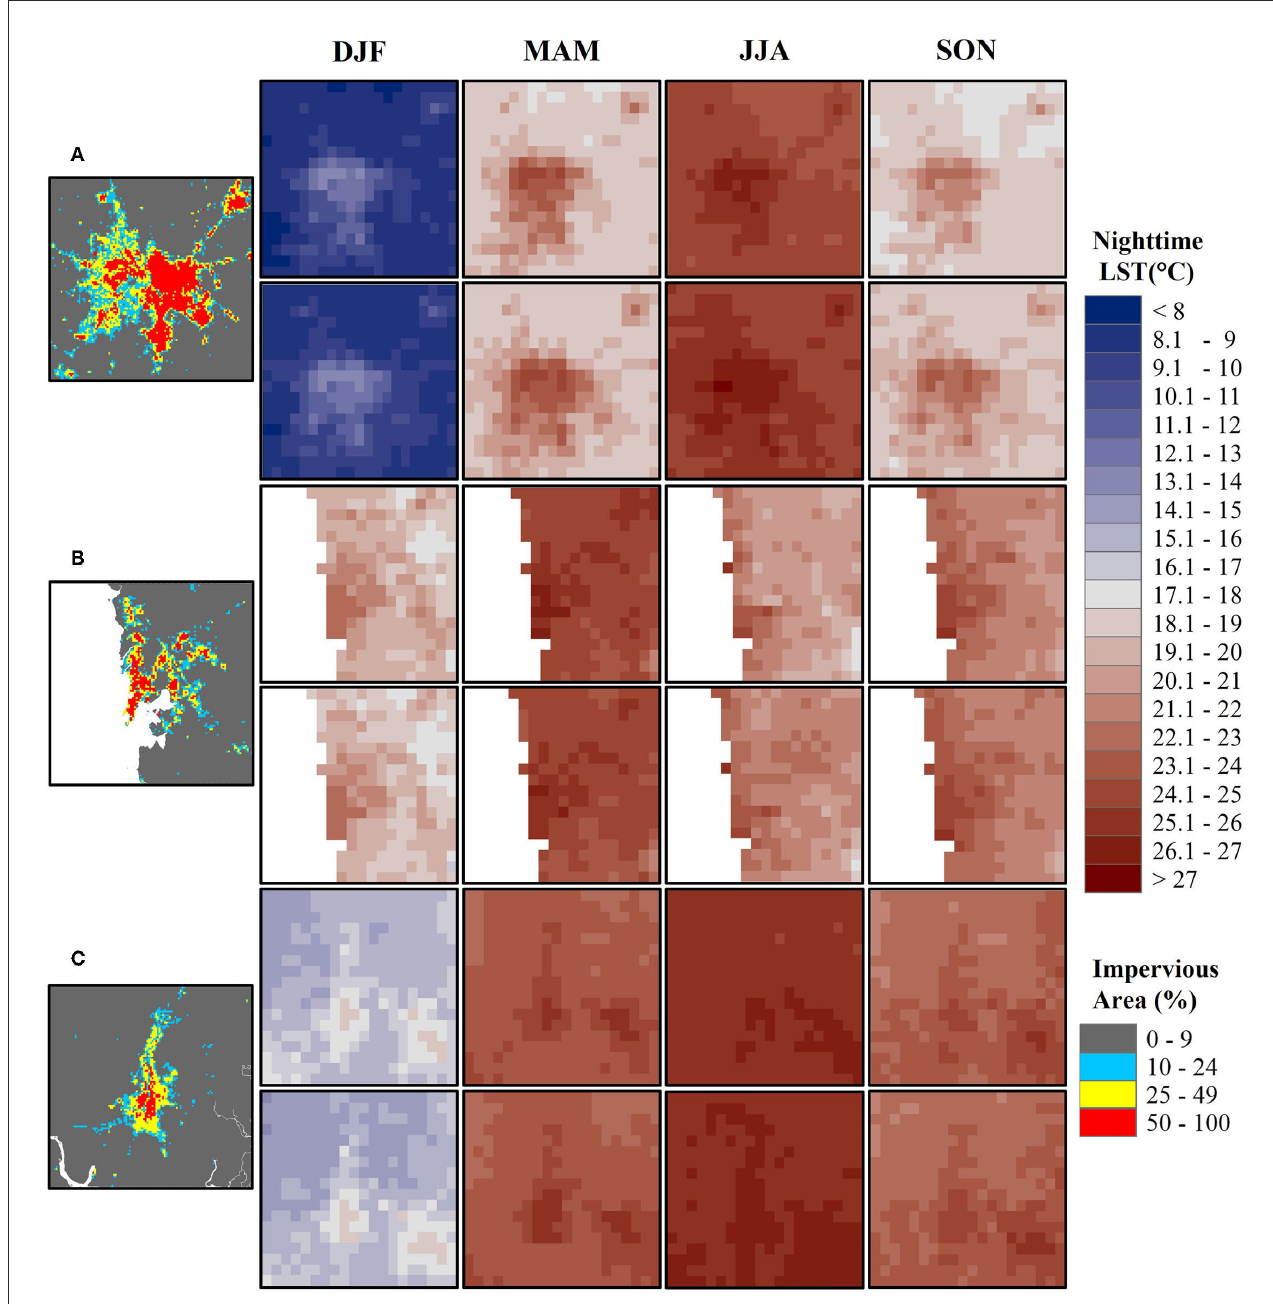
FIGURE2 Nighttime LST [ ◦ C; blue to red (shaded)] computed seasonally for December-February (DJF), March-May (MAM), June-August (JJA), and September-November (SON) for cities (A) Delhi, (B) Mumbai, and (C) Kolkata. For each city shown, the upper panels represent nighttime LST for the 2001–2010 decade, and the lower panels represent nighttime LST for the 2011–2020 decade. SUHI formation during the night in the cities is clearly discernable in regions of greater impervious area percentage. Impervious area for the year 2010 (Source: Wang et al., 2017) is classified into